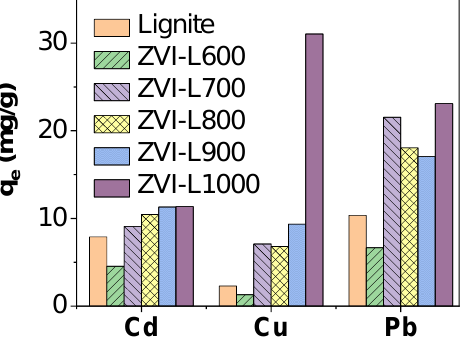
Figure 2. Comparison of heavy metal uptake capacities of lignite and ZVI-LX synthesized at 600 – 1000